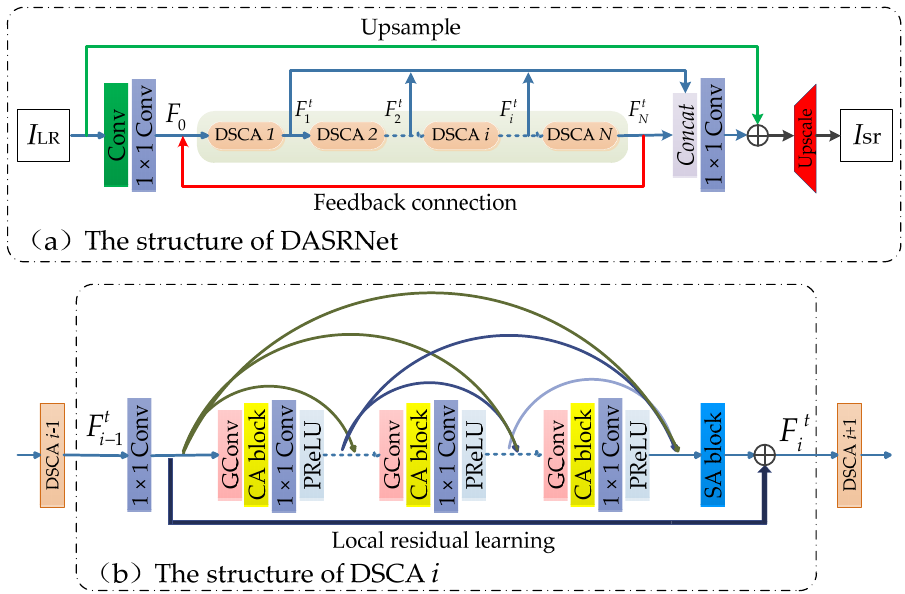
Figure 2. Our proposed DASRNet. The structure of DSCANet is shown in ( a ) and the structure of the dense spatial and channel attention module (DSCA) module is shown in ( b ). ⊕ means element-wise summation; the red and green arrows in ( a ) indicate feedback connections and global residual skip connections, respectively; “GConv” in ( b ) is composed of “deconvolution + PReLU + Conv + PReLU”. The shallow feature extraction part comprises a Conv layer and a 1 × 1 Conv